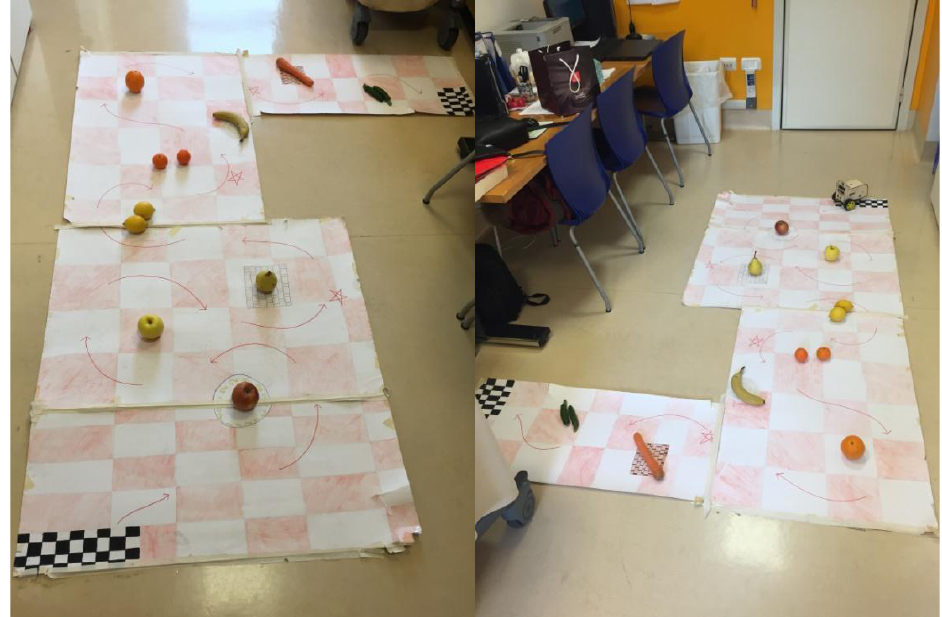
Figure 2. Example of complex obstacle course for 9- to 11-year-old